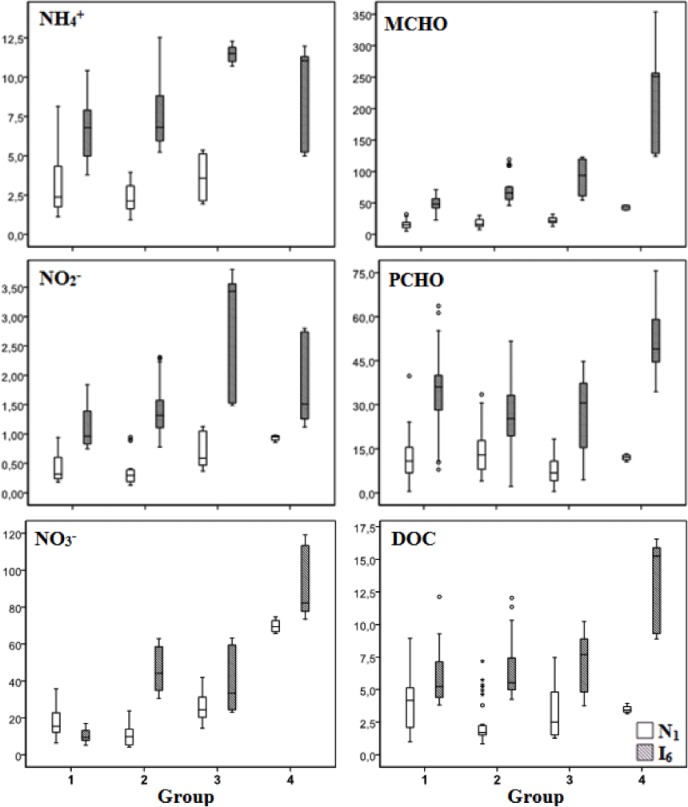
Boxplots of the concentrations of nitrate (μM), nitrite (μM), ammonium (μM), mono carbohydrates (MCHO, μM.C), polycarbohydrates (PCHO, μM.C) and DOC (mg L-1) within the different groups of samples at the marine (station N1) and brackish water (station I6) zones of the estuary Ria de Aveiro.